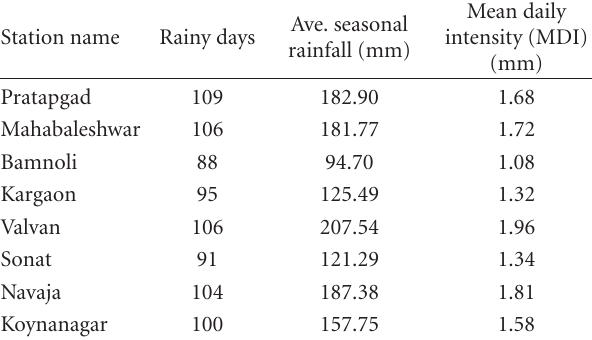
Table 6: Number of rainy days (N.R.D.) and mean daily intensity (M.D.I.) and average seasonal rainfall for the stations in the Koyna